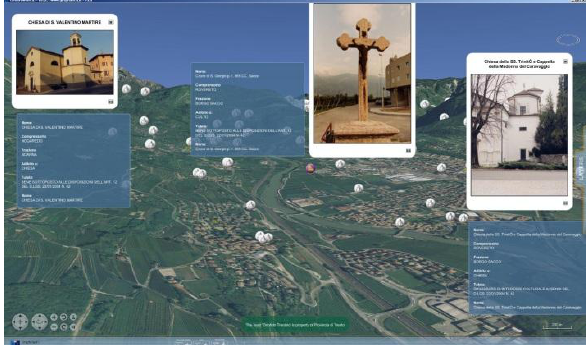
Figure 3: a screenshot showing the various cultural resources available in the